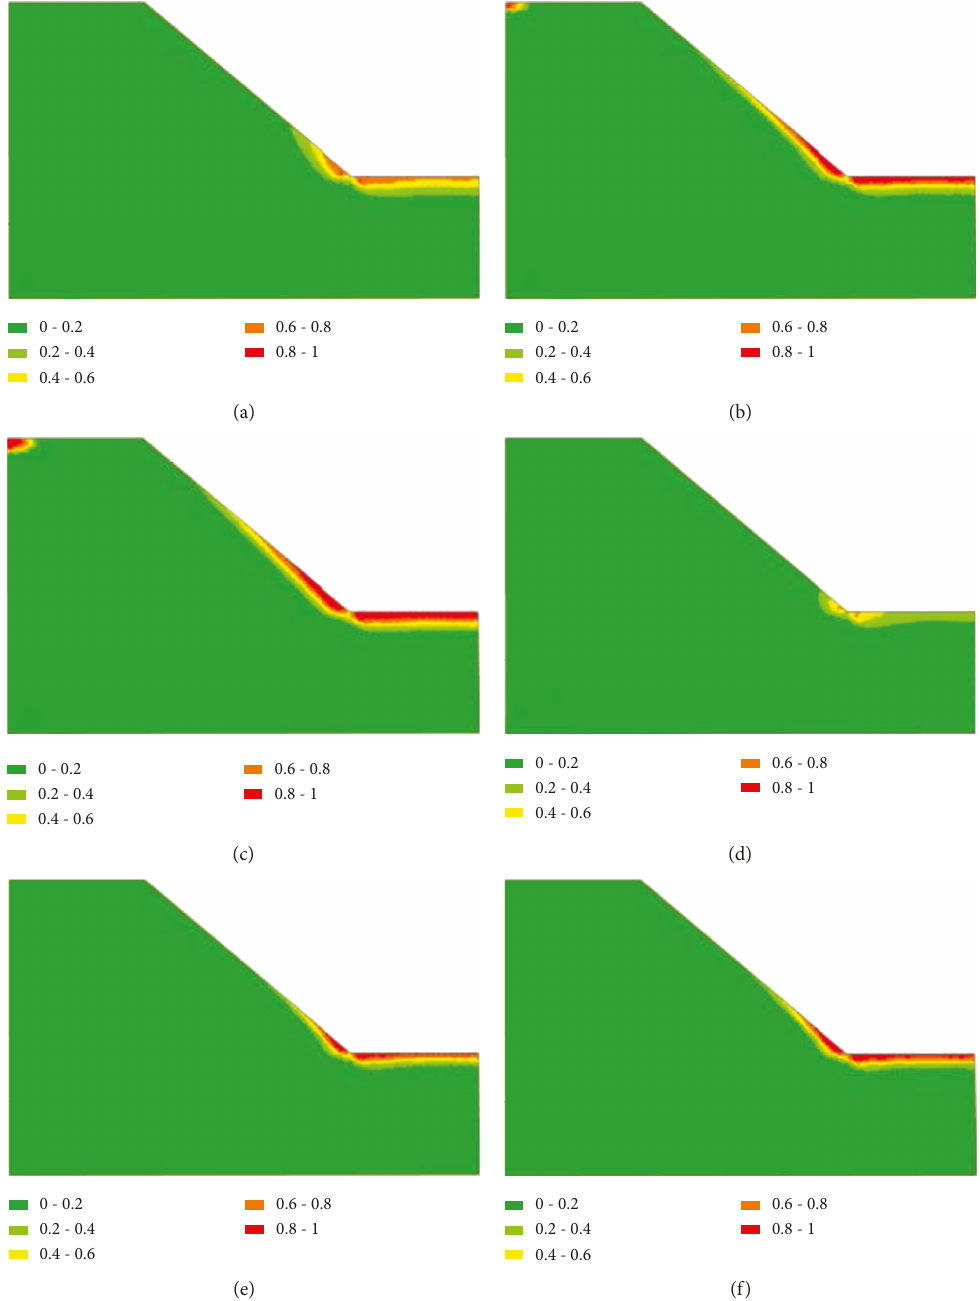
Figure 11: Results of slope failure probability in di ff erent soil slopes at 0, 24, and 48 hours under rainfall conditions: (a) 0 hours in the loam slope; (b) 24 hours in the loam slope; (c) 48 hours in the loam slope; (d) 0 hours in the silt slope; (e) 24 hours in the silt slope; (f) 48 hours in the silt